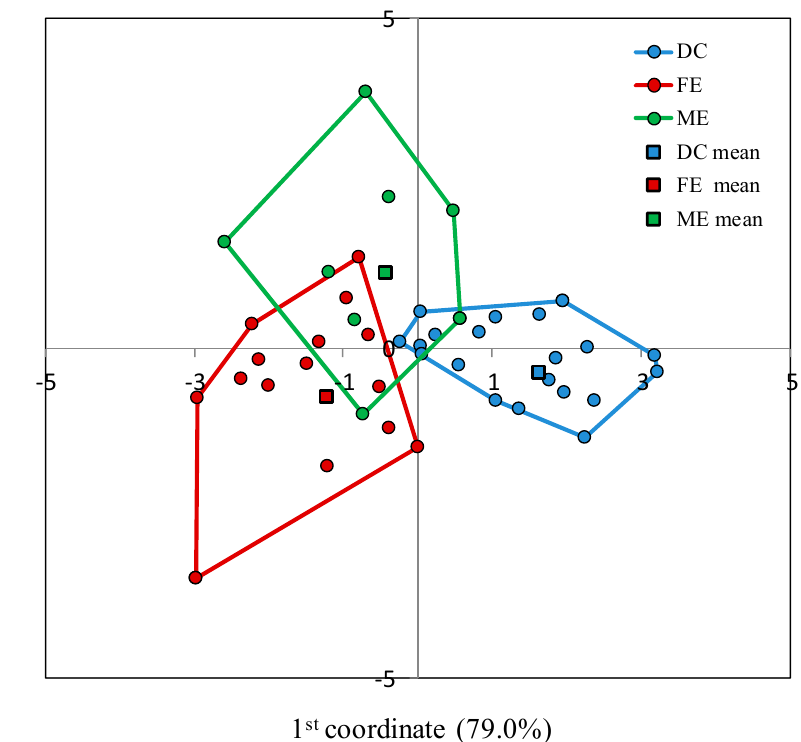
Figure 2. Results of canonical variate analysis of financial ratios concerning the variability of food enterprises. Explana- enterprises. Explanation: DC—dairy cooperatives, FE—feed companies, ME—meat tion: DC—dairy cooperatives, FE—feed companies, ME—meat enterprises.